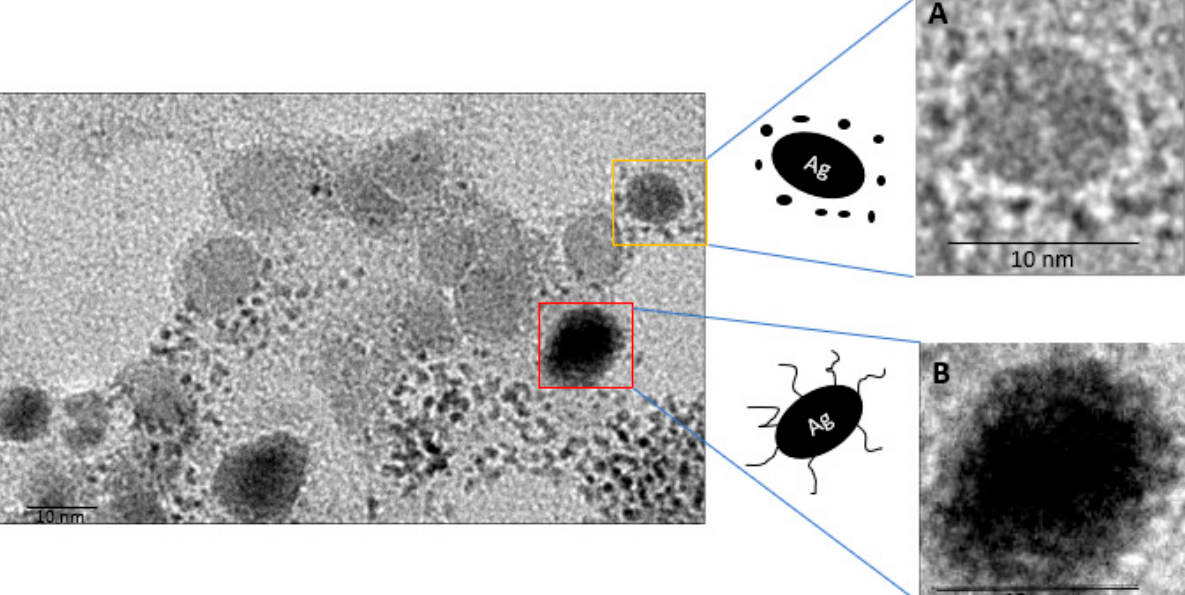
Figure 3. Presents the different sizes of AgNPs. ( A ) core-shell particles of AgNP. ( B ) AgNP coated with ethanolic extract of propolis. The scale bar is 10 nm.